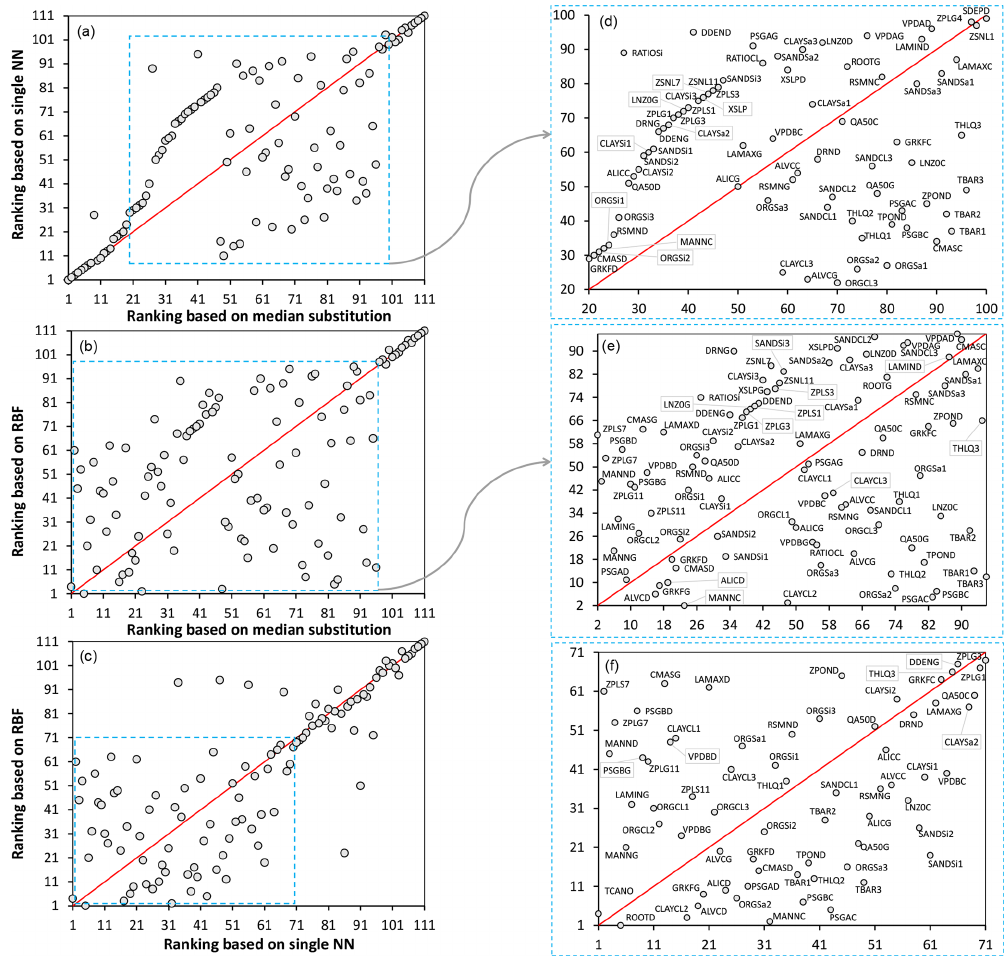
Figure 14. Comparing rankings of the MESH model parameters obtained by different crash-handling strategies using the STAR-VARS algorithm. Panels (d) , (e) , and (f) show a zoomed-in view of panels (a) , (b) , and (c) , respectively. The red line is the ideal (1 : 1) line. Note that a ranking of 1 represents the least influential and a ranking of 111 represents the most influential